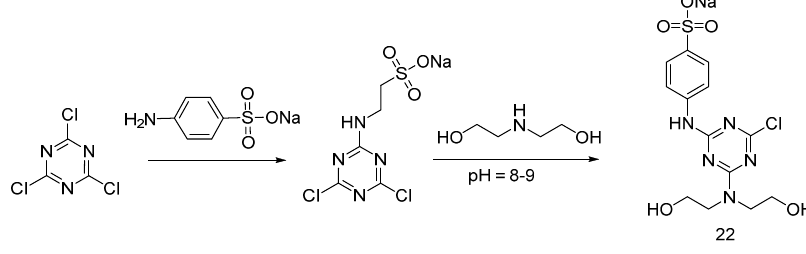
Figure 14. Synthesis of S-N flame retardant containing triazine ( 22 ).